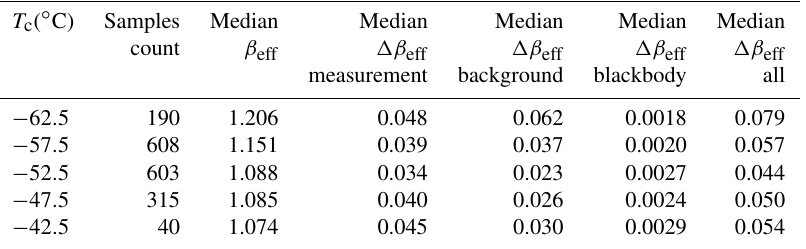
Table 3. IIR median β eff (see Fig. 6a) and estimated uncertainty (cid:49)β eff during SPARTICUS. See Sect. 2.2.4 and the appendix for